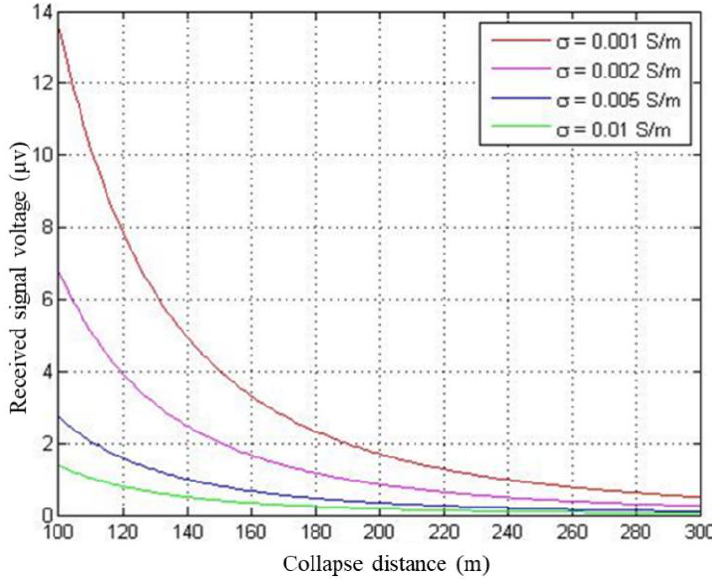
Figure 3. Relation between the received voltage and collapse distance.